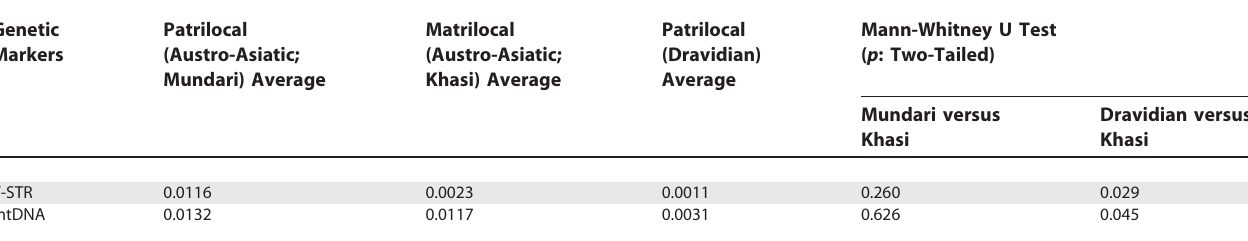
Table 2. Index of Probability of Identity Based on mtDNA HVS1 and Y-STR among the Patrilocal and Matrilocal Groups Genetic